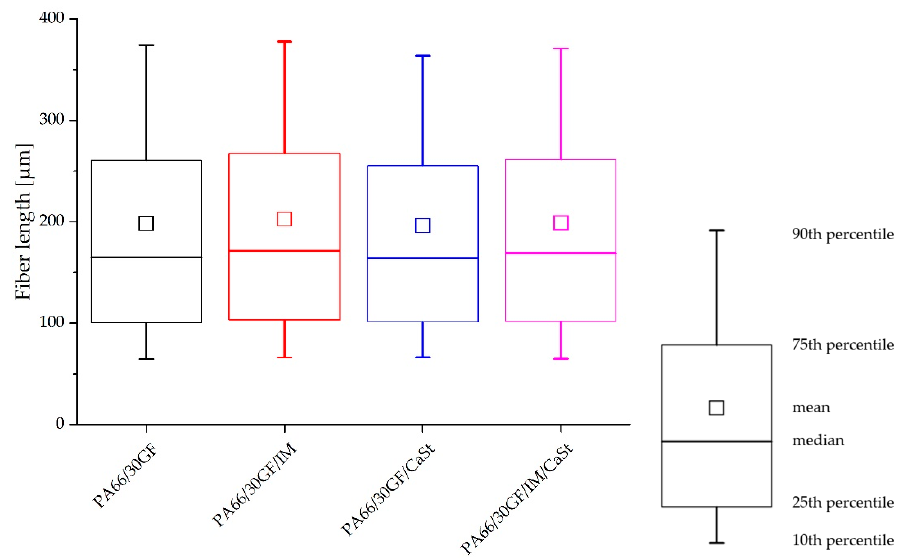
Figure 5. Fiber length in tensile specimen shown in boxplots from 90th percentile to 10th